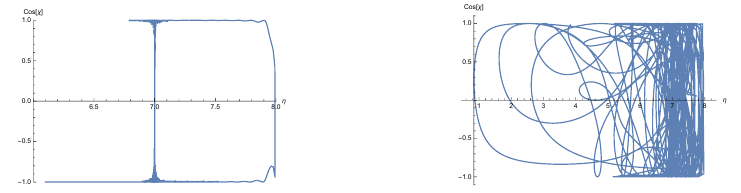
Figure 3 . Plots of example trajectories in the (cid:17) ( (cid:28) ) ; cos( (cid:31) ( (cid:28) )) plane in the one-kink space time. Left we have E = 0 : 05 and on the right E = 5 : 0.